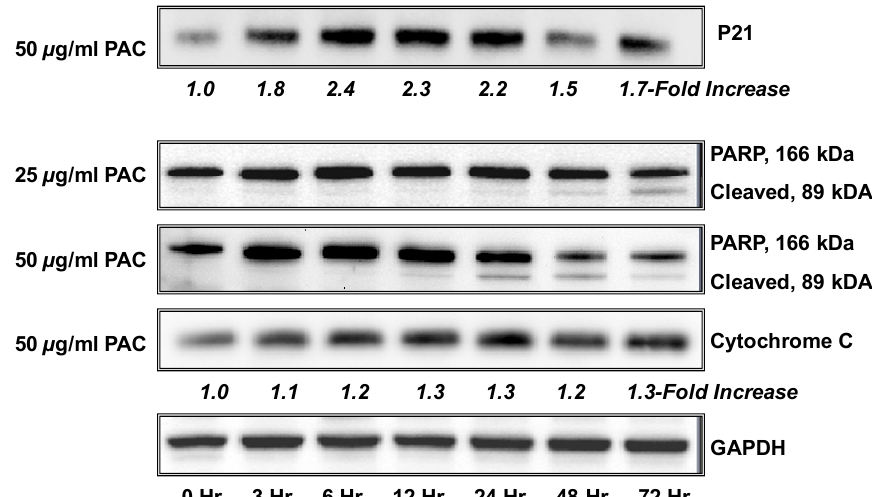
Figure 3. PAC treatment is associated with time-dependent changes in the expression of cell cycle regulatory and apoptotic molecules. NCI-H460 cells (1.0 × 10 5 cells) were